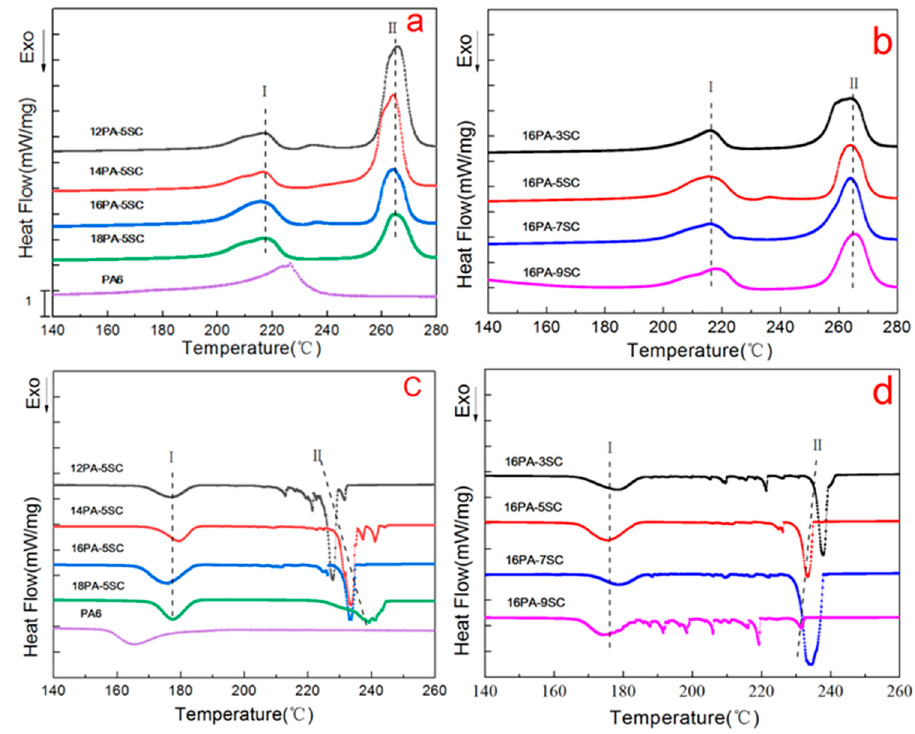
Figure 4. Differential scanning calorimetry (DSC) patterns of raw PA6 and PA foams. ( a ) and ( b ): first melting scans; ( c ) and ( d ): first cooling scans. Table 1. Crystalline melting temperature and crystallinity of PA